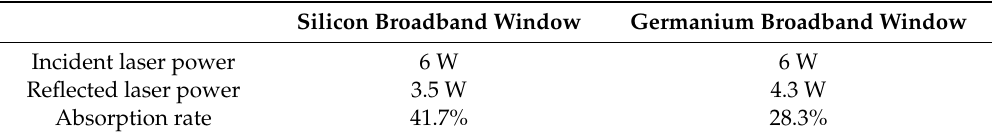
Table 5. Absorption rate of the 1.03 µ m laser by a flat window.